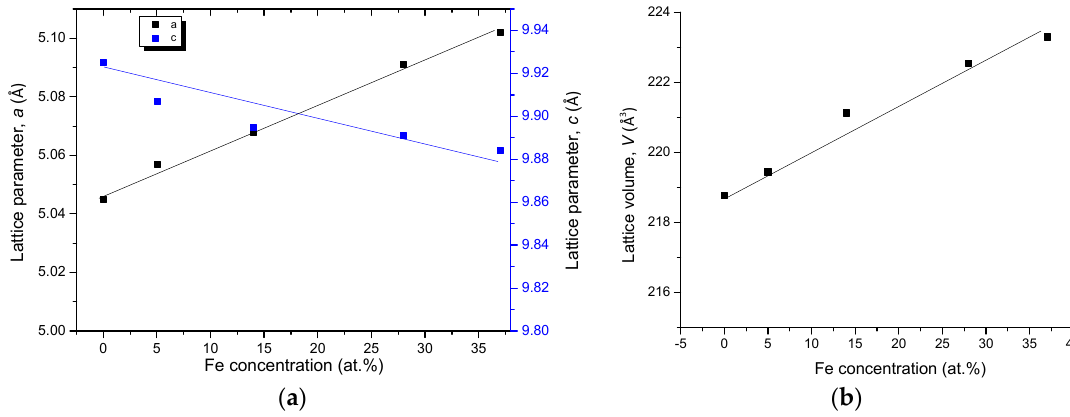
Figure 21. Cell parameters a and c ( a ) and lattice volume V ( b ) with Co concentration for the Ce 3 (Co, Fe) 11 B 4 from KAs 10–13.